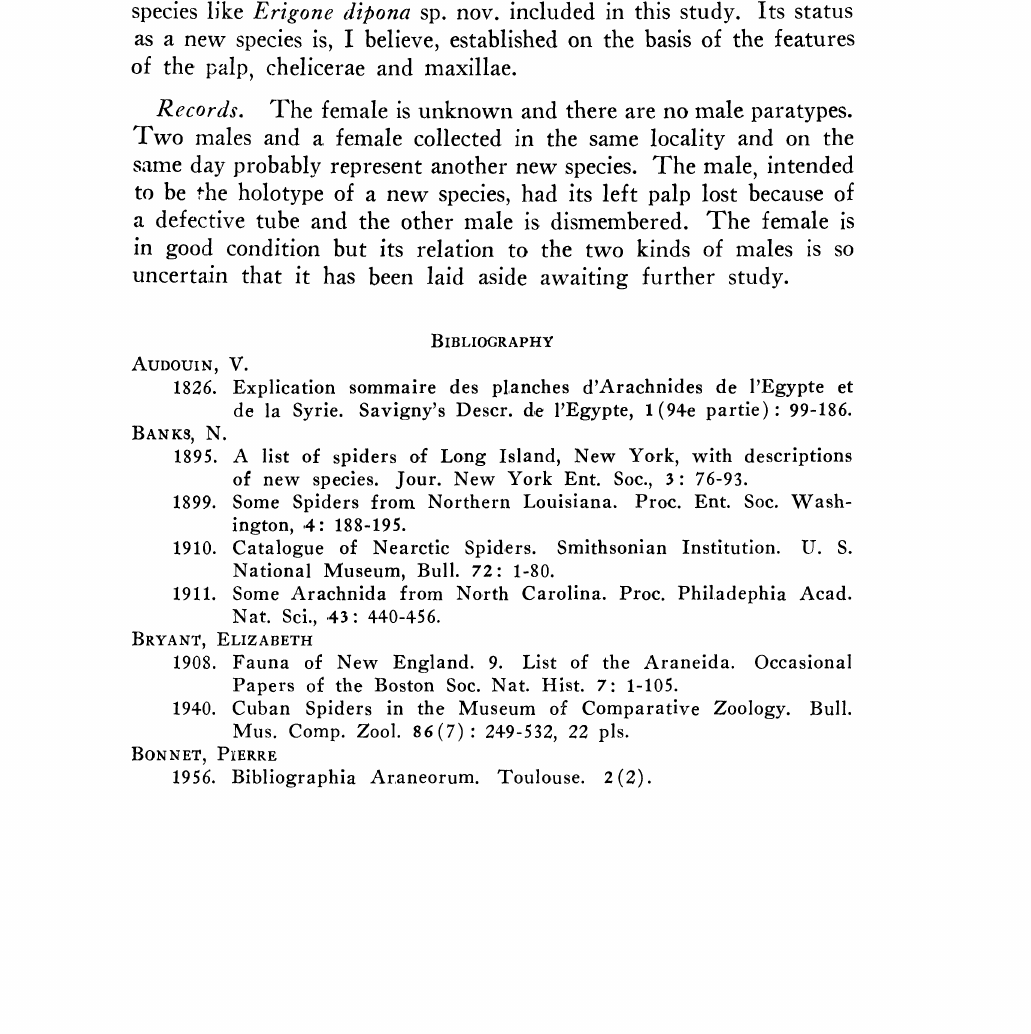
Figure 29. Lip: considerably wider than long; with a conspicuous distal border. Sternum: typical of males of the genus as observed in this study. Legs: I---423 in order of length; with few true spines but with many bristles and ,several trichobothria. Palp: trochanter with a rather poorly developed protuberance; femur with small cusps; other important features essentially as shown in Figures 3o-3. Ab- domen: typical of males of the genus. Color in alcohol: carapace very light yellowish brown; very little black pigment in ocular area; mouth parts nearly like carapace with variations; sternum very light grayish; abdomen nearly white with faint